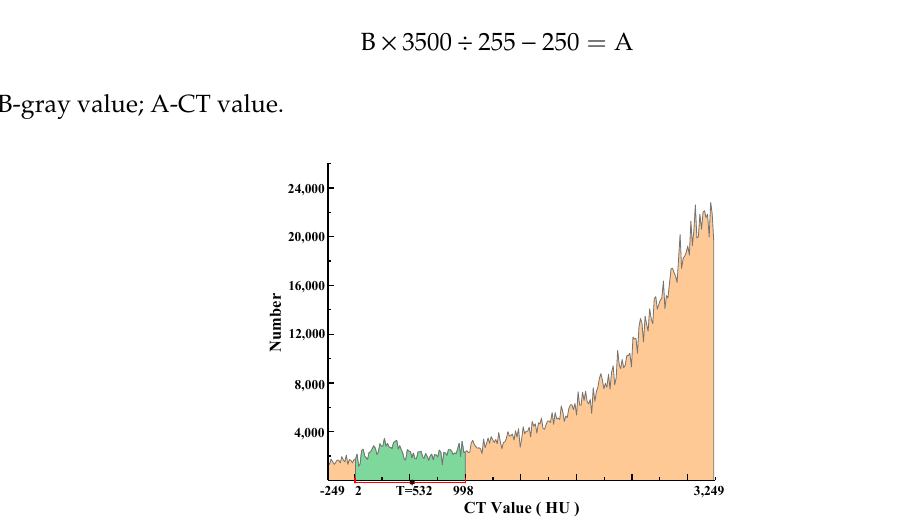
Figure 5. Image Segmentation Schematic Diagram.